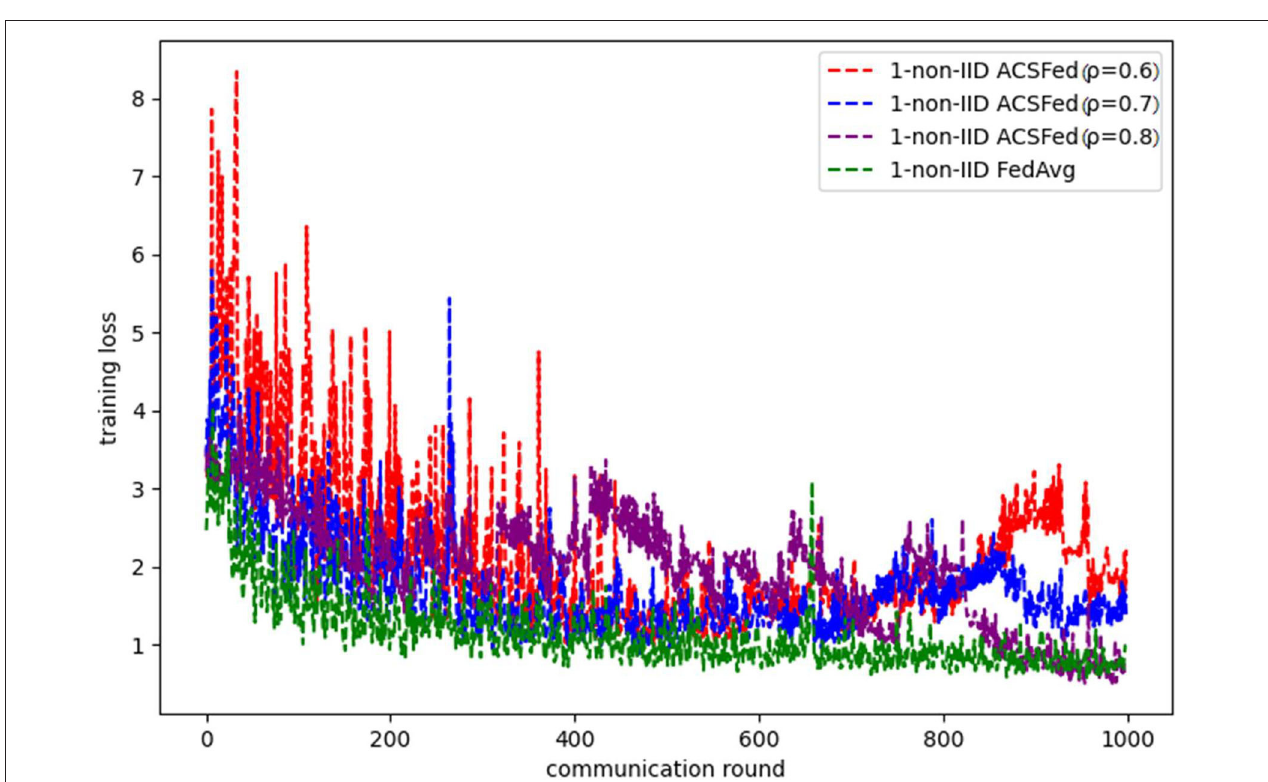
FIGURE 7 | Training loss on fashion MNIST in the 1-class non-IID scenario.